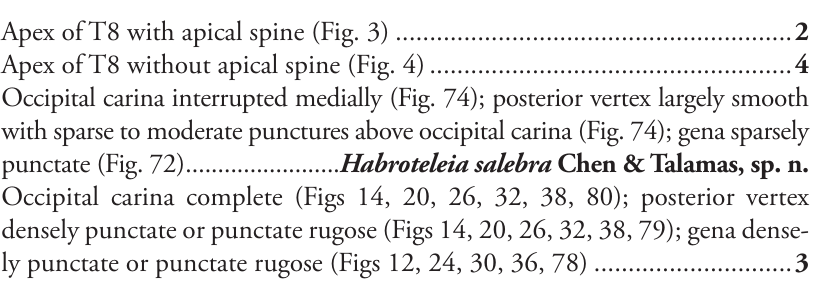
Key to females (unknown for H. ruficoxa (Kieffer)) 1 T1 with horn (Figs 14, 20, 26, 32, 38, 62, 76) ........................................... 2 – T1 without horn (Figs 16, 22, 79, 87) ........................................................ 4 2 Posterior vertex largely smooth with sparse to moderate punctures above oc- cipital carina (Fig. 74); gena sparsely punctate (Fig. 72); mesepisternum an- teroventral to mesopleural depression largely smooth with sparse punctures (Fig. 72) ................................. Habroteleia salebra Chen & Talamas, sp. n. – Posterior vertex densely punctate to punctate rugose (Figs 13, 20, 26, 32, 38, 61); gena densely punctate to punctate rugose (Figs 12, 18, 24, 30, 36, 60); mesepisternum anteroventral to mesopleural depression densely punctate to punctate rugose (Figs 12, 18, 24, 30, 36, 60) .............................................. 3 3 Median propodeal projection short (Figs 14, 20, 26, 32, 38); T6 in female longitudinally striate, with fine punctures in interstices (Fig. 88) .................. ........................................................................ Habroteleia flavipes Kieffer – Median propodeal projection long (Figs 56, 62); T6 in female densely punc- tate and without longitudinal striae (Fig. 89) ................................................ ............................................ Habroteleia persimilis (Kozlov & Kononova) 4 Central keel of frons present (Figs 80, 86); upper frons densely punctate (Figs 80, 86); transverse sulcus on T2 present (Figs 79, 87) ................................. 5 – Central keel of frons absent (Figs 45, 51); upper frons sparsely punctate (Figs 45, 51); transverse sulcus on T2 absent (Figs 16, 22) .................................... .......................................... Habroteleia mutabilis Chen & Talamas, sp. n. 5 Apex of T6 in female rounded (Fig. 81); posterior vertex punctate rugose (Fig. 80) ....................................... Habroteleia soa Chen & Talamas, sp. n. – Apex of T6 in female with small spine (Fig. 5); posterior vertex smooth with sparse punctures (Fig. 85) ..... Habroteleia spinosa Chen & Johnson, sp. n.